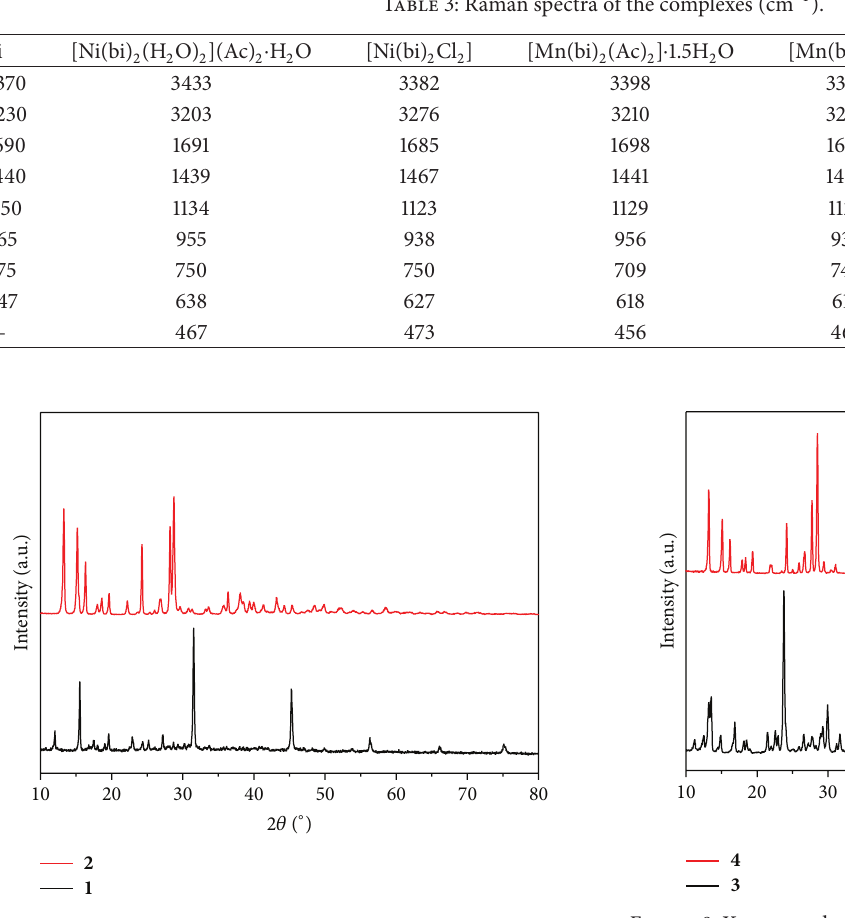
Figure 7: X-ray powder diffraction patterns of complexes 1 and 2 . Figure 8: X-ray powder diffraction patterns of complexes 3 and 4 .